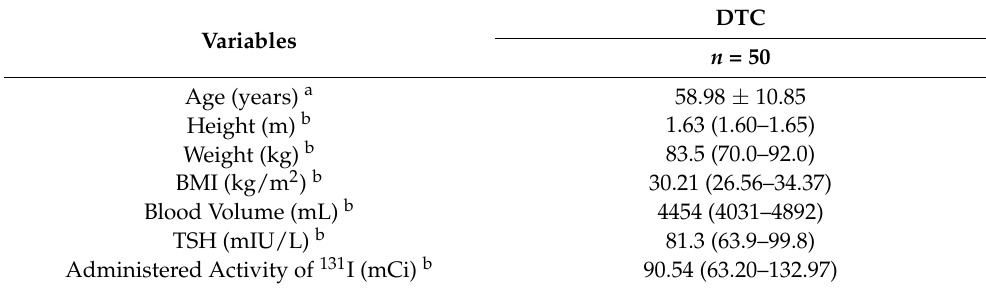
Table 1. Clinical data in the study group.